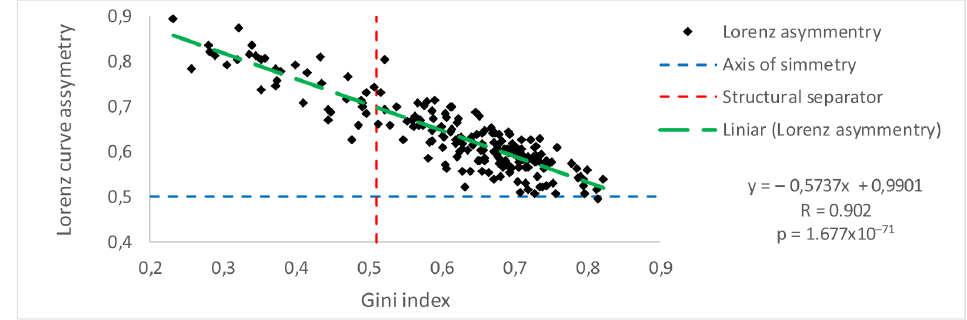
Figure 8. Linear regression of the Lorenz curve asymmetry by the Gini index (the differentiation of forest structural types is based on 0.5 and 0.51 thresholds of the dependent and predictor variable, respectively).